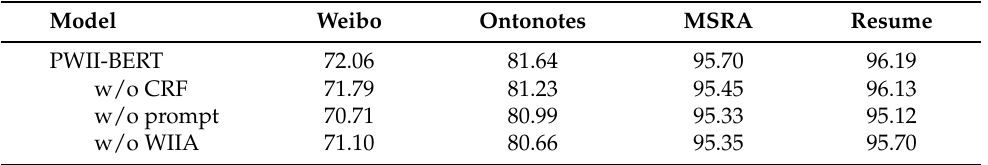
Table 4. Ablation Study on Weibo, Ontonotes, MSRA, and Resume datasets. Deletion of CRF denotes using softmax as a sequence labeling decoder instead of CRF, deletion of prompt denotes using the original Transformer structure before and after WIIA, and deletion of WIIA denotes removing the WIIA and only using the prompt-based Transformer.